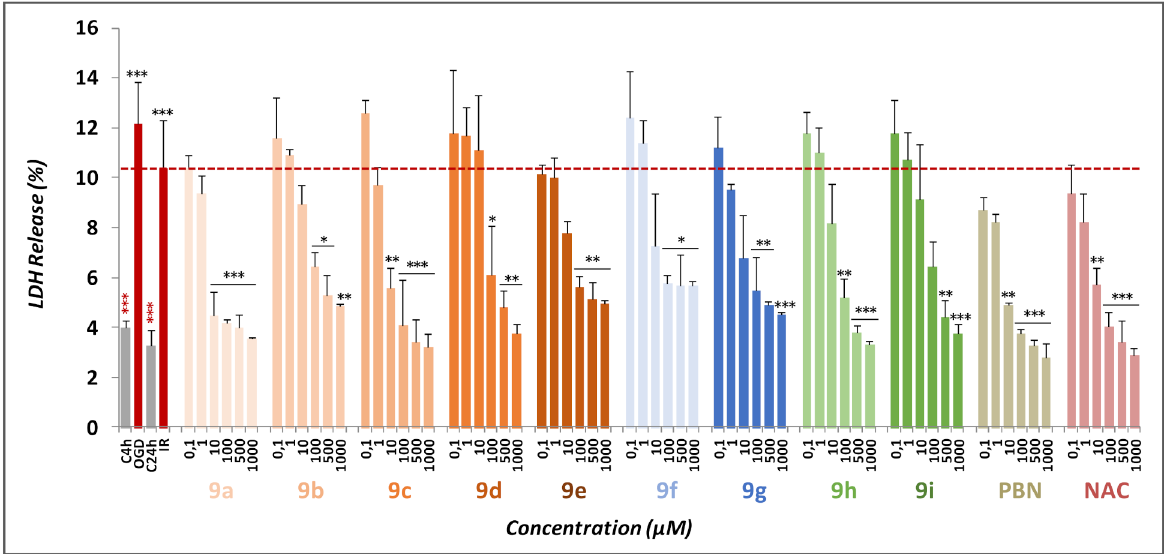
Figure 5. Antinecrotic effect of nitrones 9a – i , PBN , and NAC in SH-SY5Y cells after OGD-OGR (IR). Bars represent cell percent LDH release after OGDR (IR) in cells treated in the absence or presence of indicated compounds and concentrations. Values represent the mean ± SEM of three experiments, carried out in triplicate, and compare the effect of OGD and IR versus their respective controls (red ***) or the effect of the different compounds after IR (24 h) with IR (24 h) alone (red dotted line) in the absence of these compounds (black ***). Statistical analysis was performed as indicated in Figure 3. * p < 0.05, ** p < 0.01, and *** p <